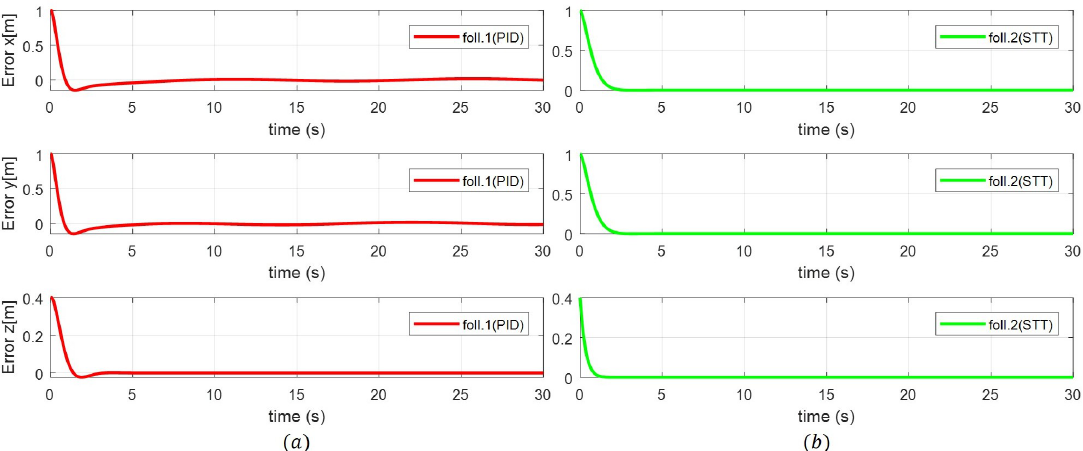
Figure 11. The formation errors for each of the three axis about the 4 π circular trajectory: ( a ) PID control method; ( b ) formation control method proposed in this